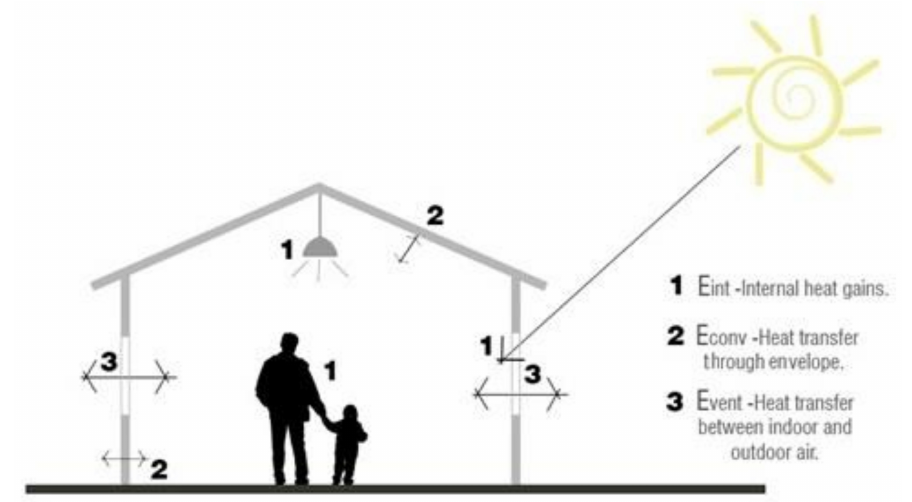
Figure 1. Di ff erent heat-flow paths within a free-running building, derived from authors’ elaboration.